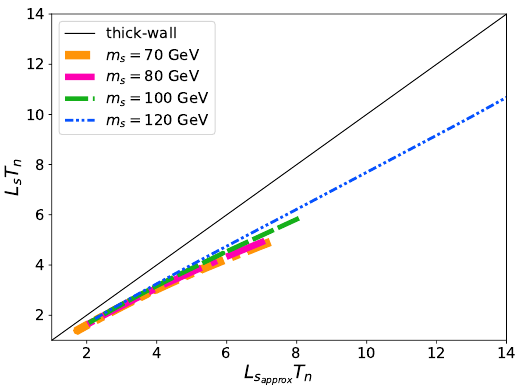
Figure 19 . Comparison between our results for the wall thickness in the singlet direction with the estimated formula eq. (8.7). The solid black line has slope one and is plotted for visual